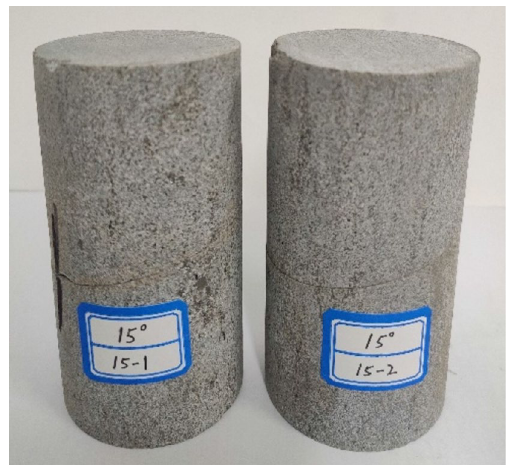
Figure 3. Rock test pieces.